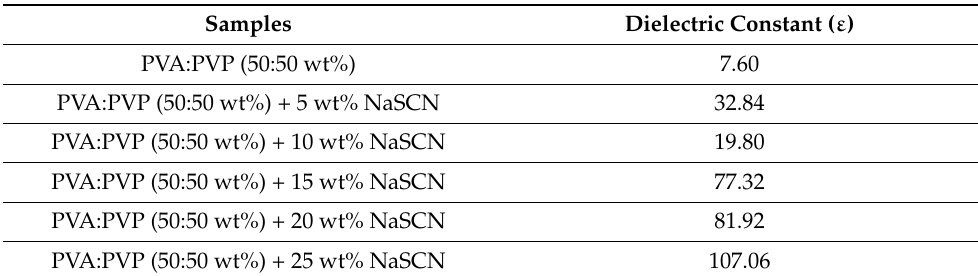
Figure 7. Dielectric constant value with different amounts of salt in PVA: PVP (50:50 wt%) polymer blends at the frequency of 10 3 Hz. Table 2. Dielectric constant value with each amount of NaSCN in polymer blend salt-complex at the frequency 10 3